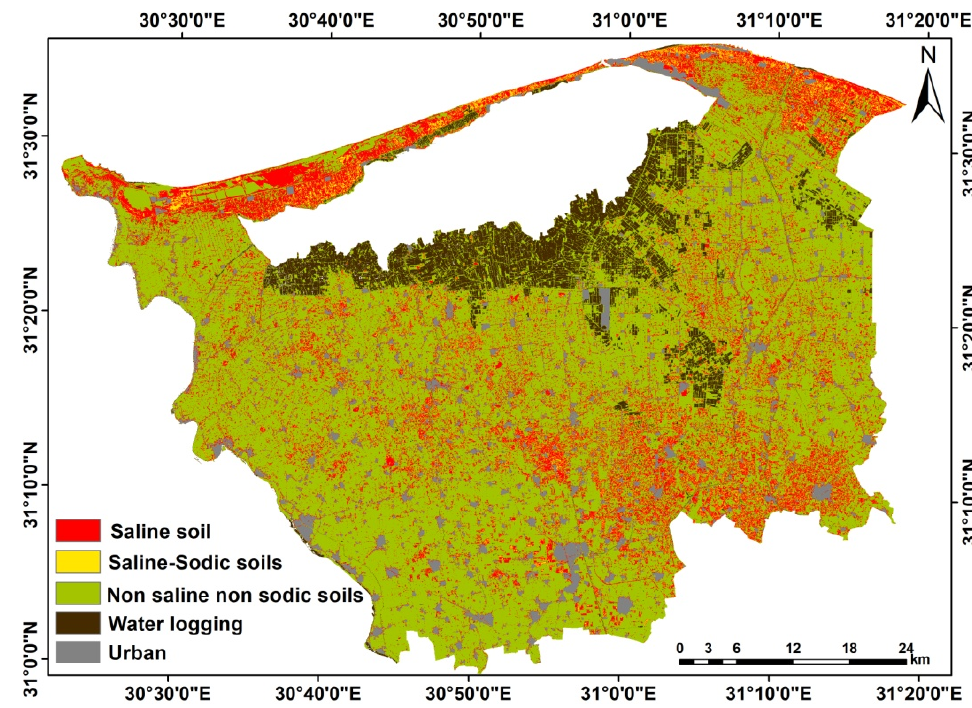
Figure 13 . A 2016 map showing the salt-affected soils in the study area.